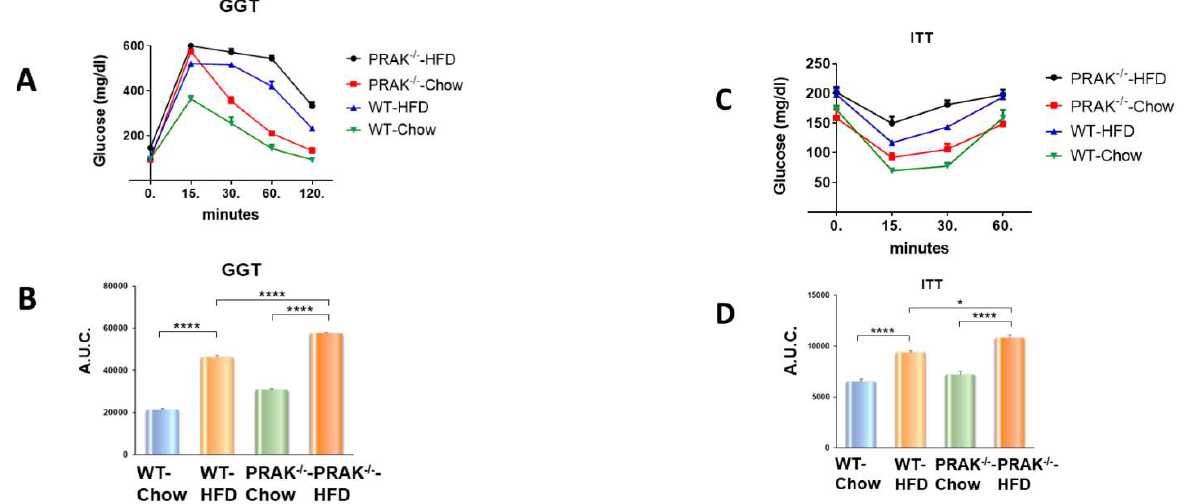
Figure 2. Deletion of PRAK enhances insulin resistance in mice exposed to HFD. ( A , B ) Glucose tolerance test. Area under curve for GTT. Data are shown as means ± SEM; **** p < 0.0001 (n = 5/each group). ( C , D ) Insulin tolerance test (ITT). Data are shown as means ± SEM * p < 0.05, **** p < 0.0001 vs. HFD. Area under curve for ITT. **** p < 0.0001 ( n = 5/ each group).